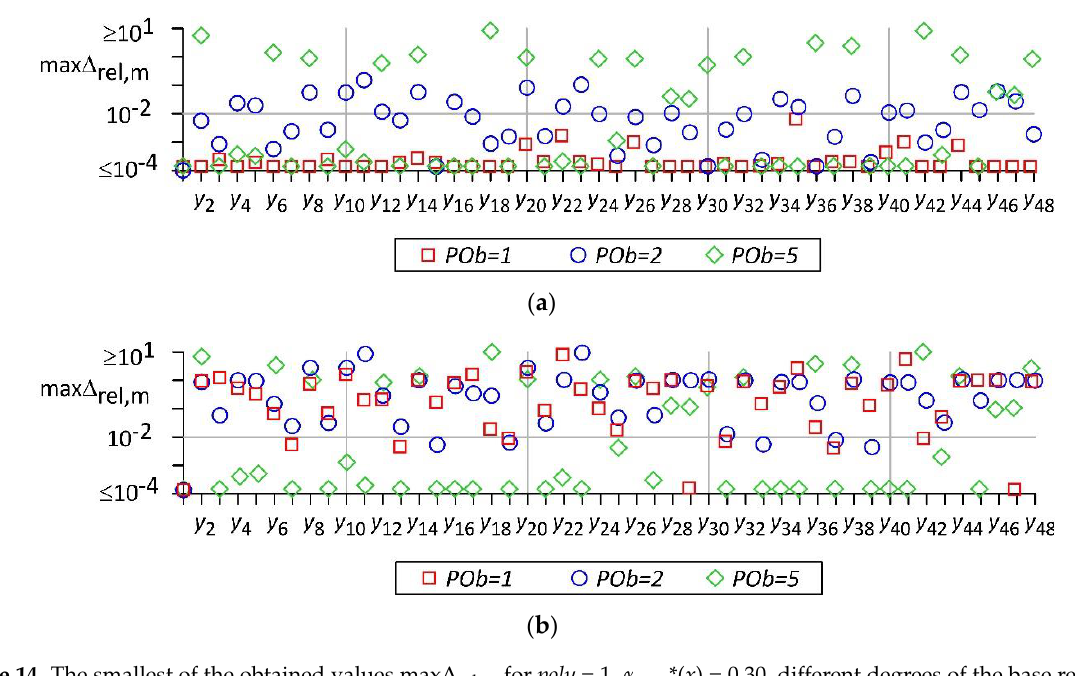
Figure 15. Scheme of the numerical example concerning steel diagrid grillages. The FEM analysis was carried out with the use of the civil engineering system RO- BOT. Its usage was driven by the fact that this system enables both obtaining discrete solutions of a given structural problem as well as shaping and dimensioning steel struc- tures so that the analysis is fully supported by this program.